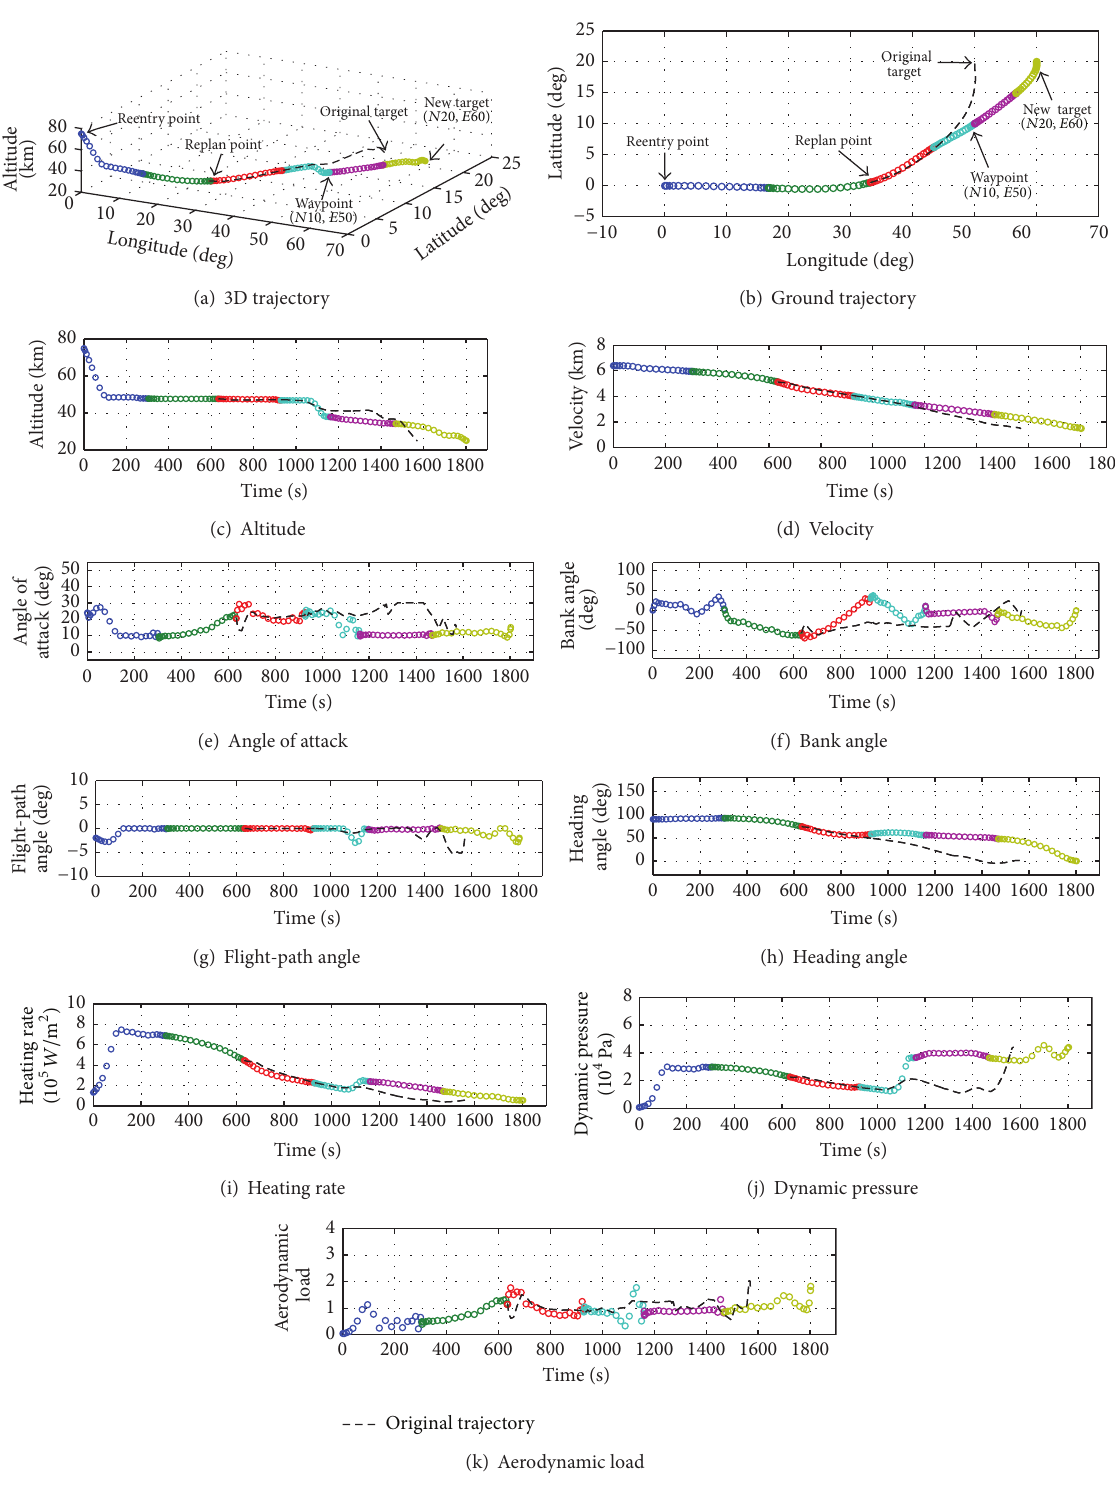
Figure 6: Numerical results of the target transition flight